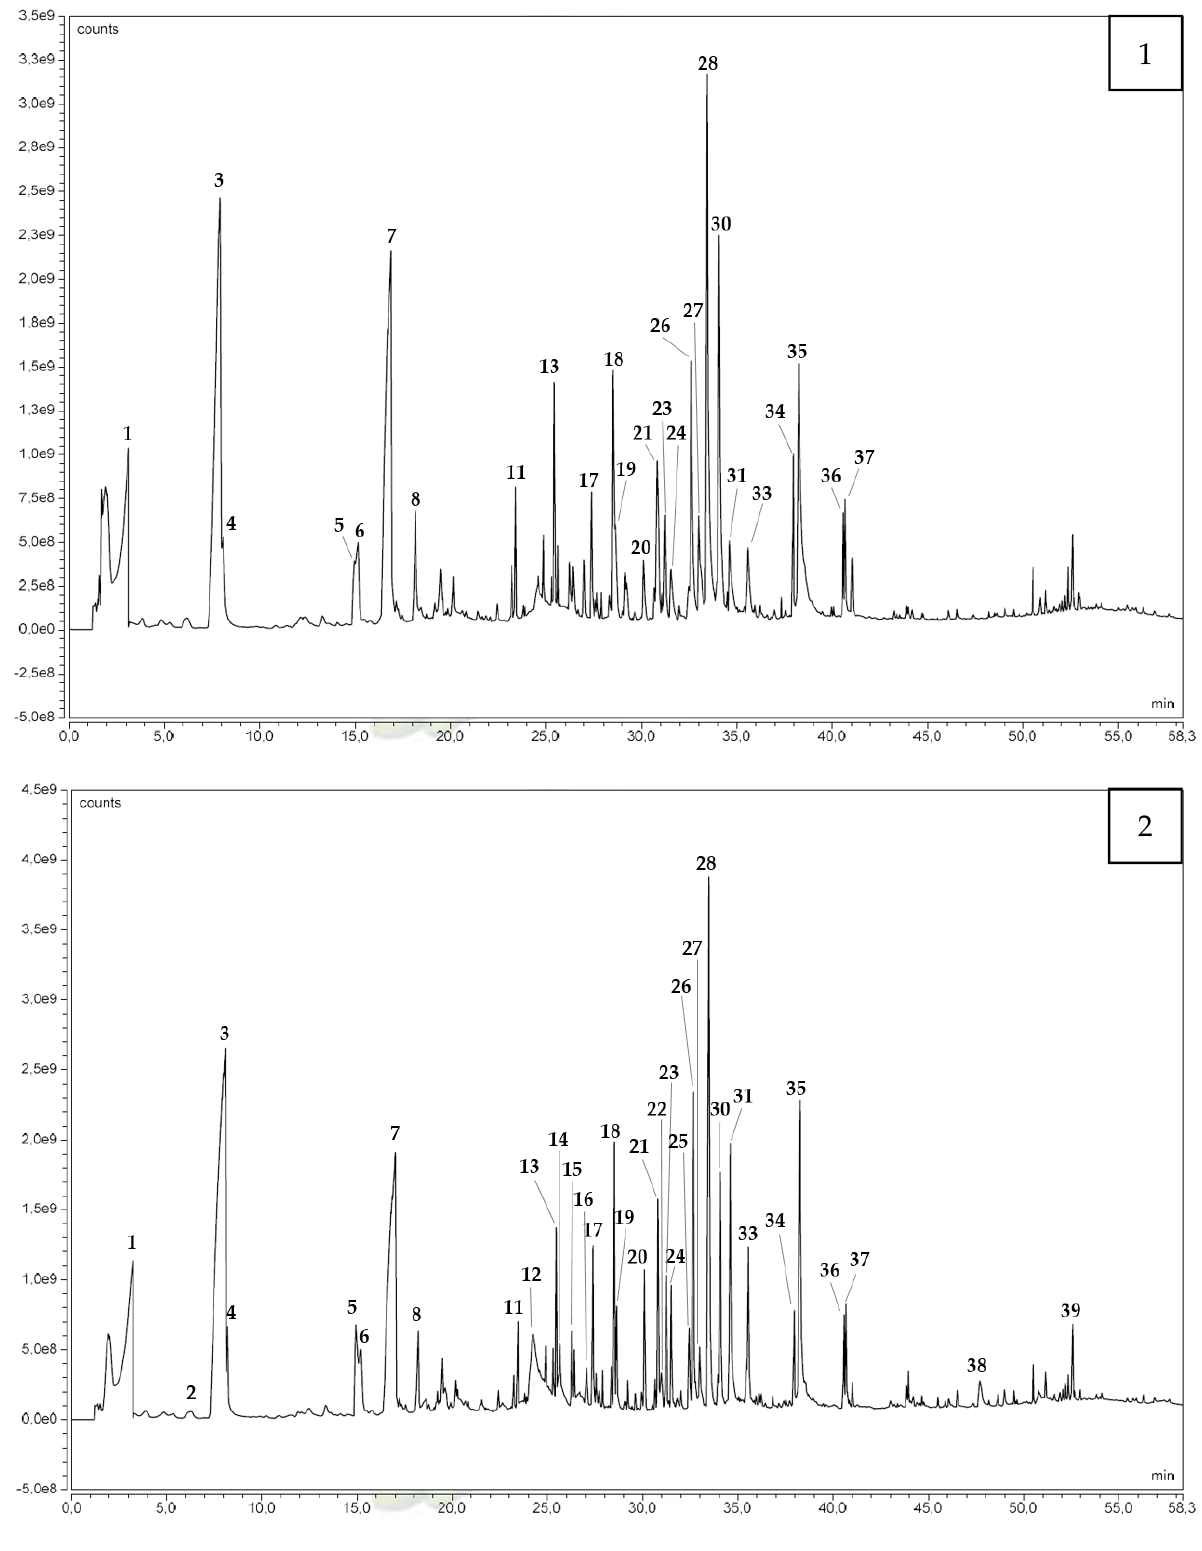
Figure 3. Chromatograms obtained by GC-MS related to the pyrolysis of heartwood ( 1 ) and related to the pyrolysis of Board A ( 2 ). Compounds are expressed with numbers corresponding to Table 3.